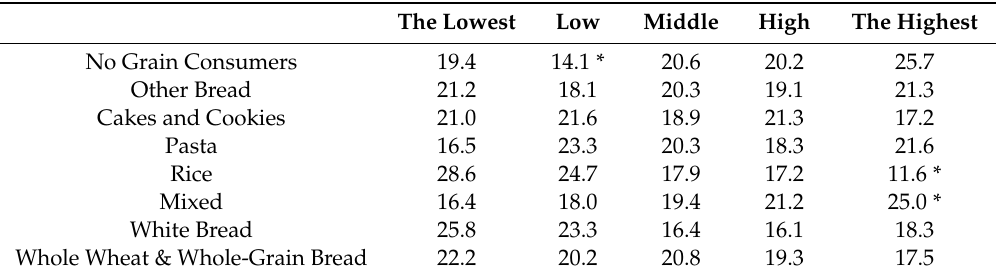
Table 5. Income distribution and GBFs dietary patterns. The Lowest Low Middle High The